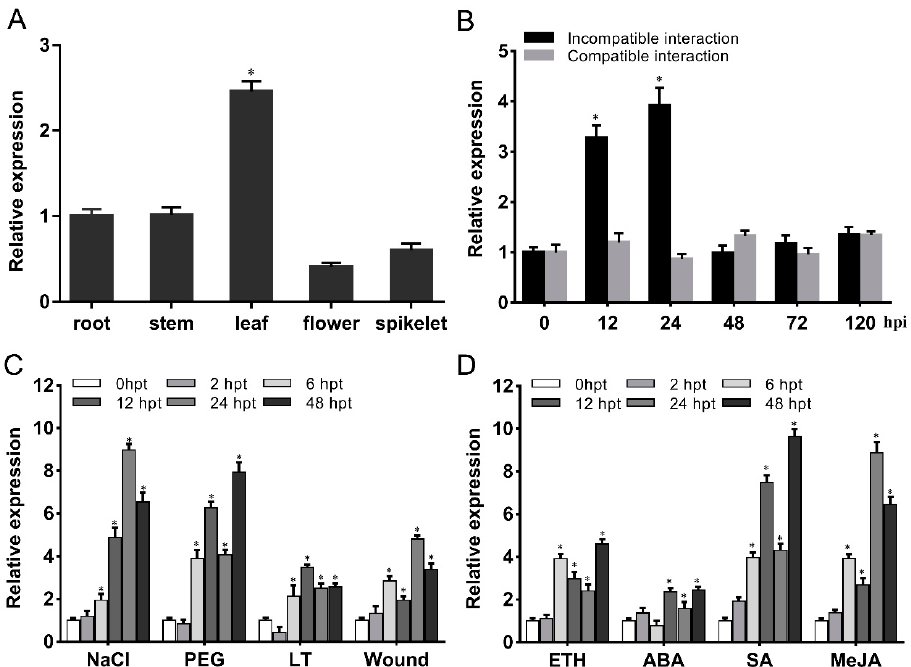
Figure 2. Expression patterns of TaG6PDH2 under different treatments. ( A ) TaG6PDH2 expression profiles in different wheat tissues. Samples were collected from roots, stems, leaves, flowers, and spikelets. Asterisks represent significant differences ( p < 0.05) compared to the root, according to Student’s t -test. ( B ) Expression patterns of TaG6PDH2 in Pst- infected wheat leaves. The wheat leaves were inoculated with Pst CYR23 or CYR31 and sampled at 0, 12, 24, 42, 72, and 120 hpi. Asterisks represent significant differences ( p < 0.05) from 0 hpi, according to Student’s t -test. ( C , D ) TaG6PDH2 expression patterns in response to abiotic stresses ( C ) and exogenous hormones ( D ). Samples were collected from treated wheat leaves at 0, 2, 6, 12, 24, and 48 hpt. Asterisks indicate significant differences ( p < 0.05) compared to 0 hpt, according to Student’s t-test. PEG; polyethyleneglycol